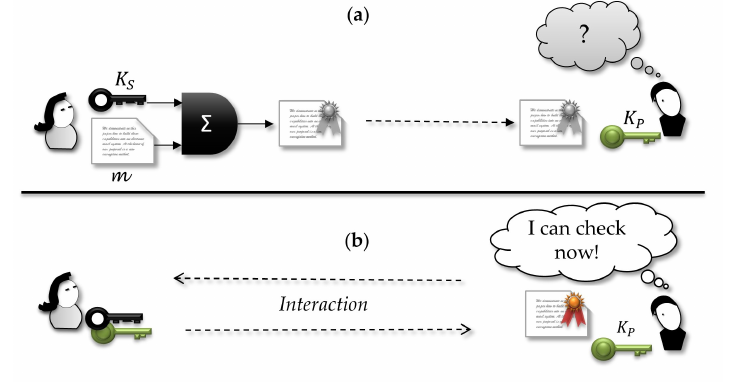
Figure 3. In undeniable signature, ( a ) the receiver is not able to verify the validity of a signature until ( b ) the signer agrees to perform a validation